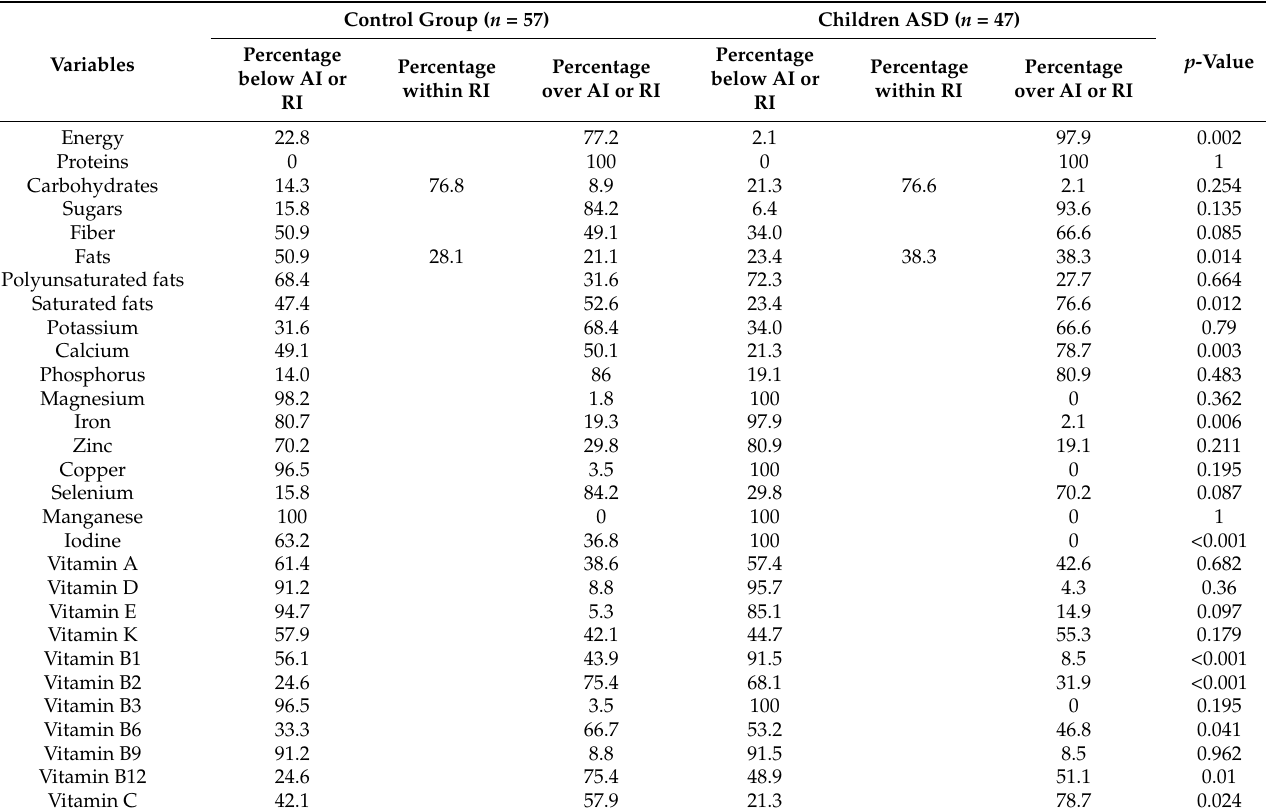
Table 4. Adequacy of nutrient intake to the European Food Safe Authority (EFSA) recommendations of Spanish preschool children with autism spectrum disorders (ASD) compared with a healthy control group.